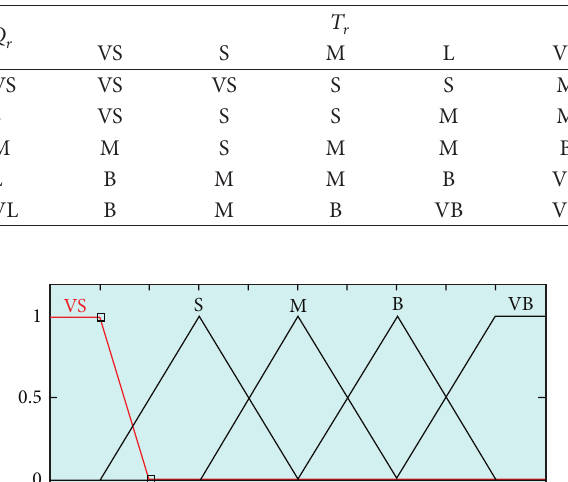
Table 1: The fuzzy rules of evaluation module for red light phase urgency degree.